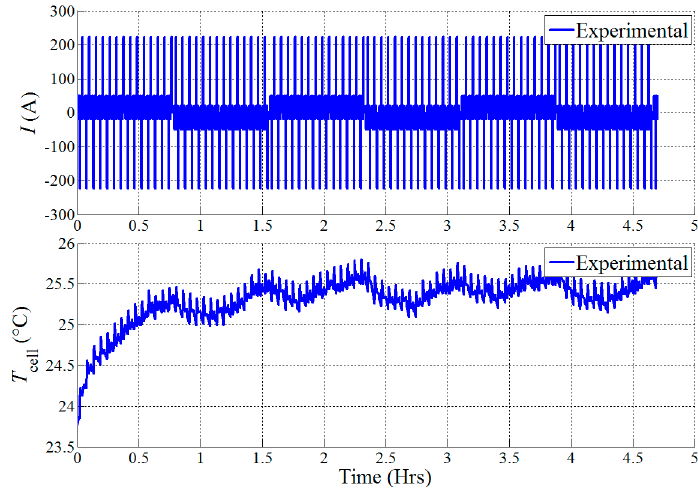
Figure 8. Test data of current and cell temperature under DST profile.